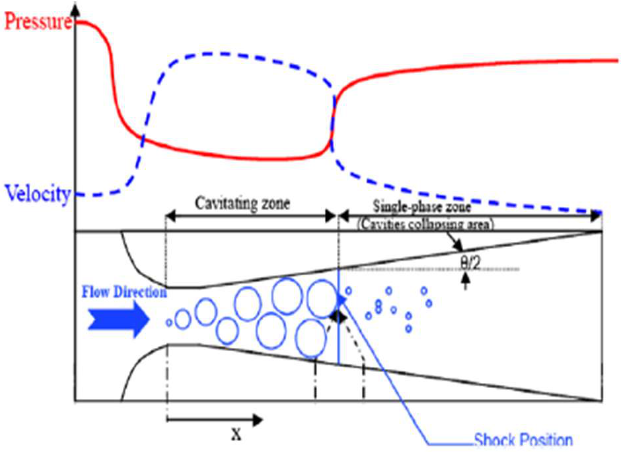
Figure 6. Schematic diagrams of NB generator based on hydrodynamic cavitation [103].